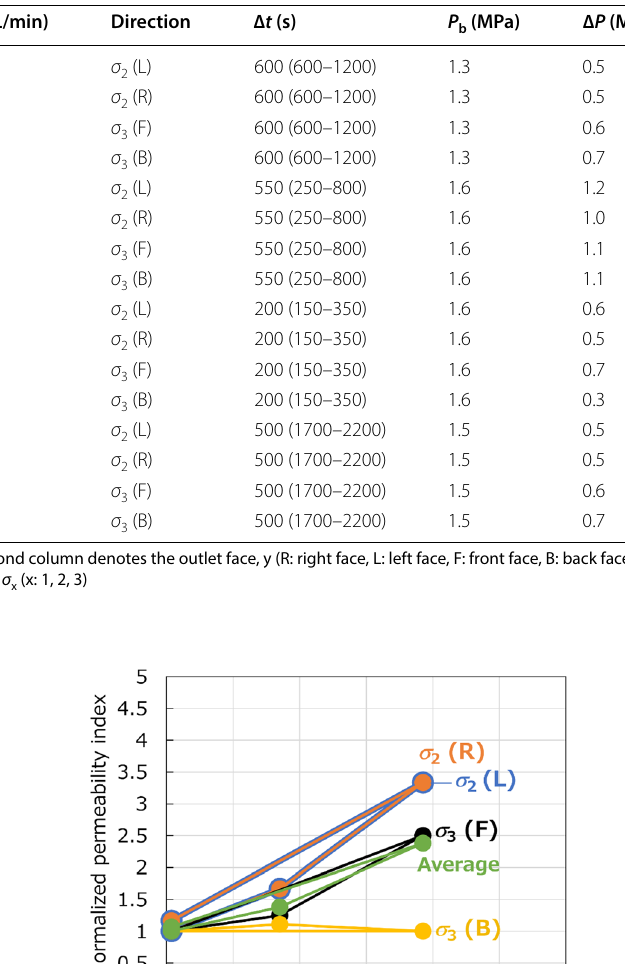
) for each direction at each flow rate in Run i